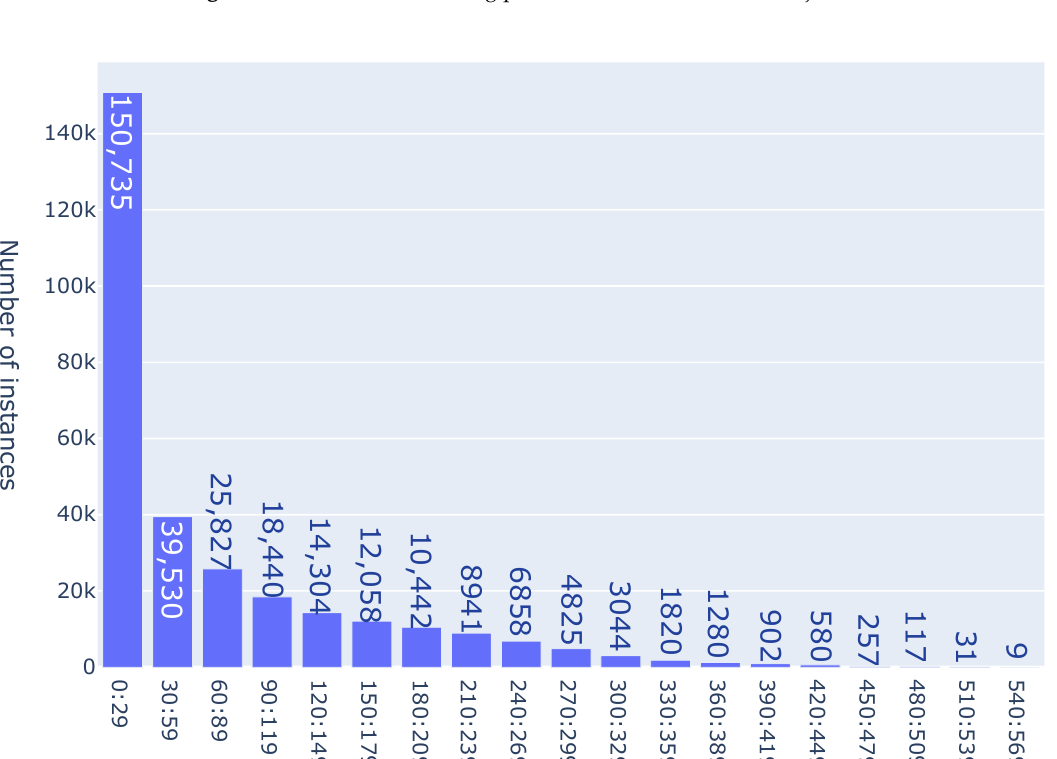
Figure 2. Number of branching points for the instances with 5 jobs.